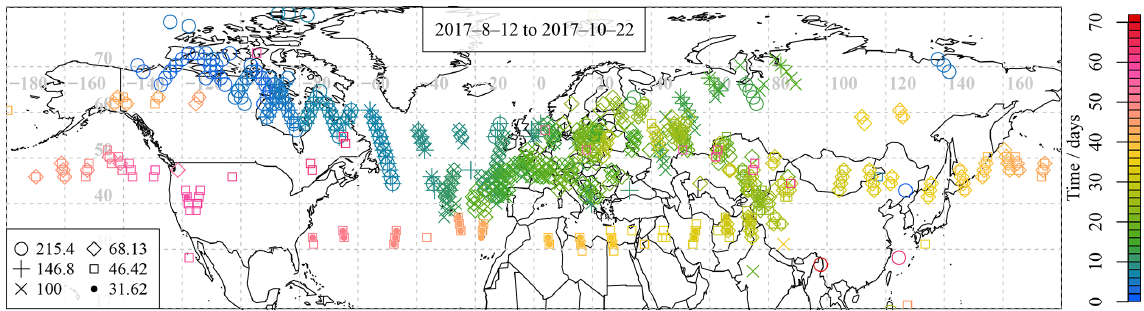
Figure 3. Map showing the locations of MLS observations of enhanced CO (defined as described in the text). Colours show time in days after 12 August 2017. Symbols show pressure level in hectopascals. The MLS measurements lie along the satellite orbit tracks; the tracks are particularly noticeable over North America and can also be seen in Fig. 1.